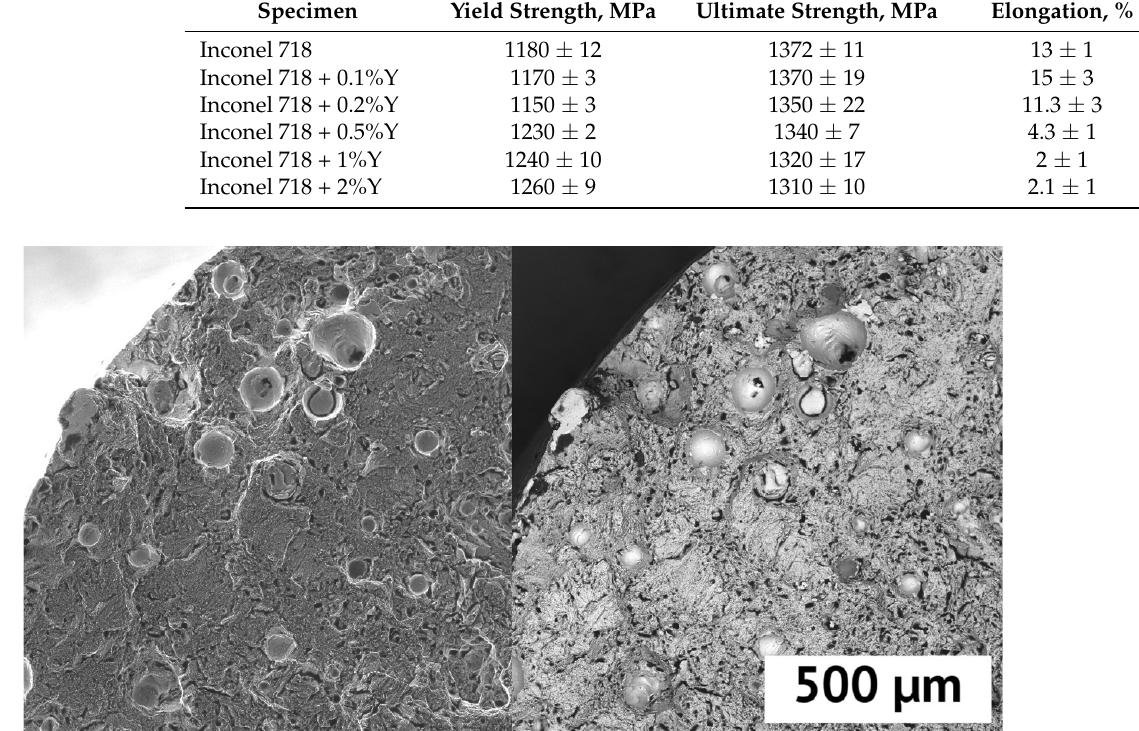
Figure 5. SEM image of the fracture of the sample Inconel 718 + 2% Y. ( Left )–SE, ( right )–BSE. On the fracture, Yttrium particles (lighter in the BSE image) are clearly visible, not com ‐